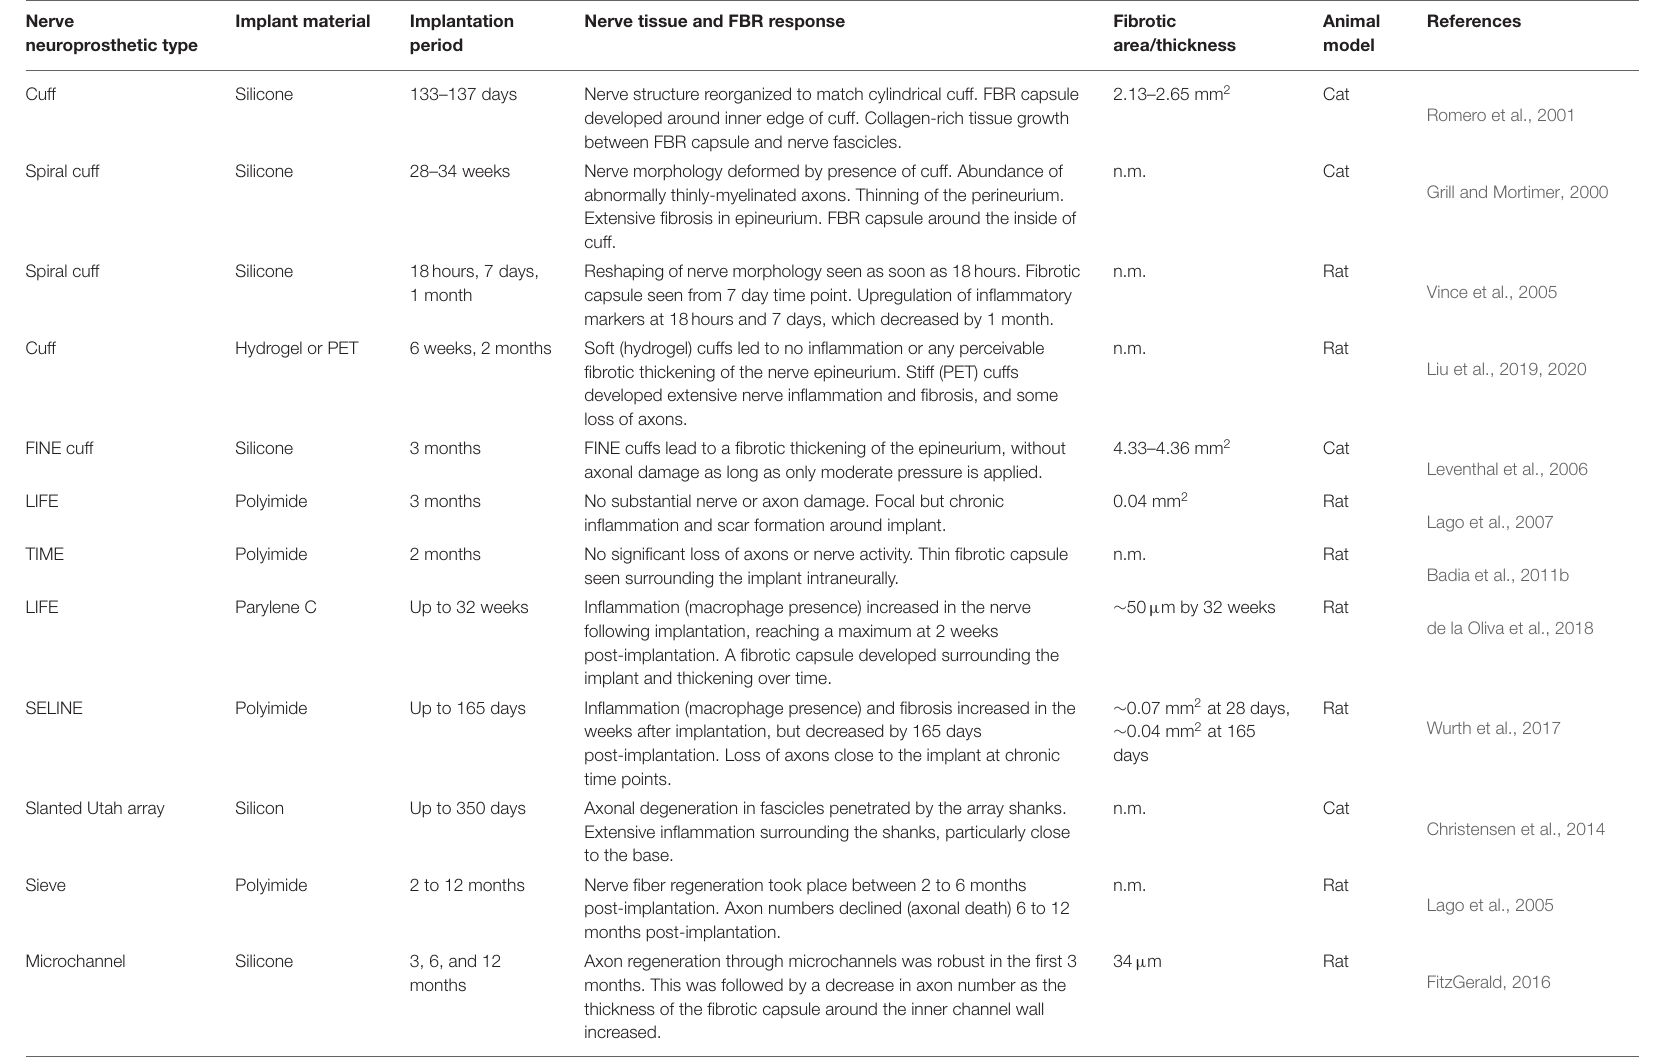
TABLE 1 | Summary and comparison of the nerve response and FBR to various classes of nerve neuroprosthetics. Nerve neuroprosthetic